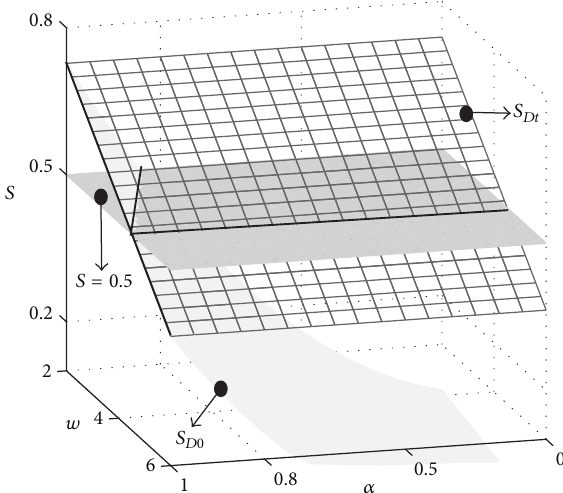
Figure 5: Service level change of the decentralized supply chain with/without RFID technology.